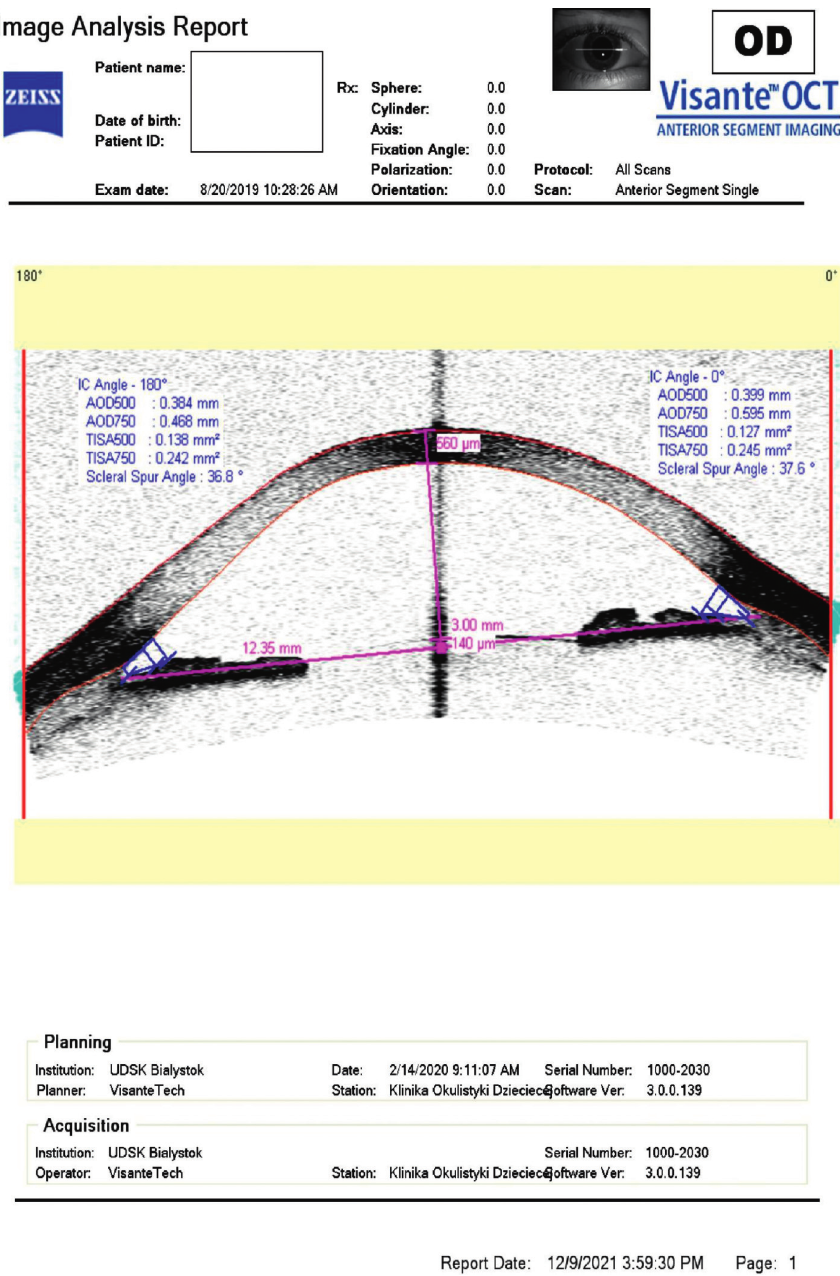
Figure 2: Flattening of the iris after